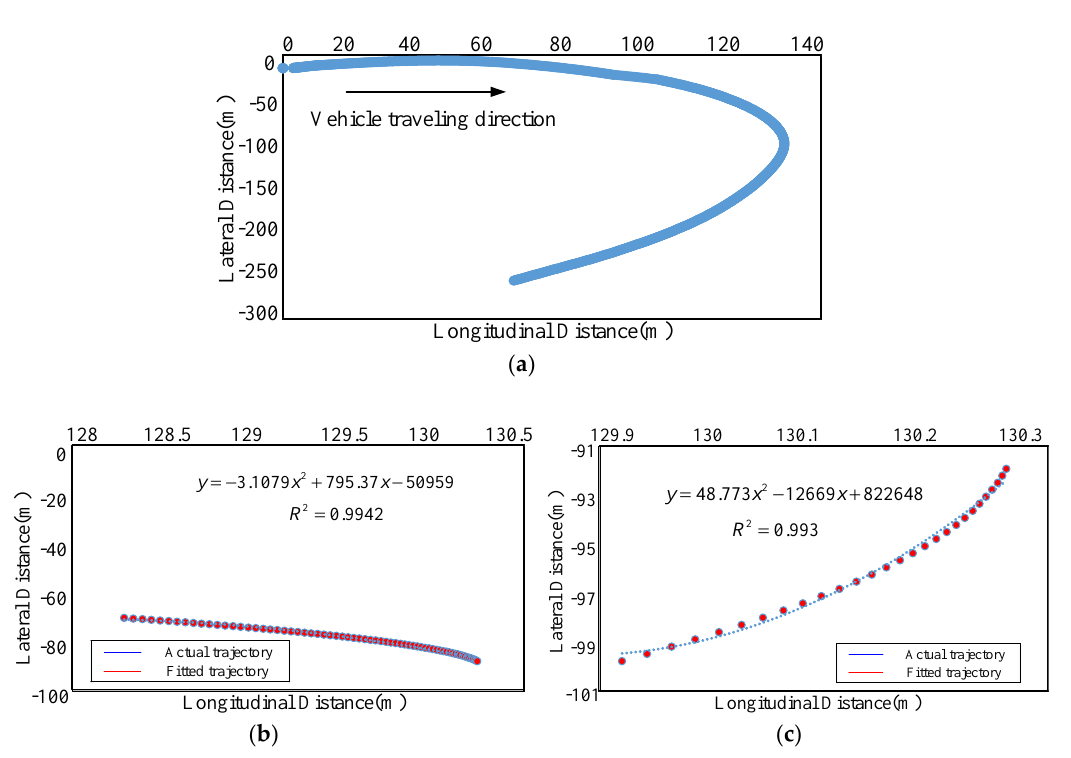
Figure 1. Trajectory fitting under normal right-steering: ( a ) Full trajectory; ( b ) The first paragraph trajectory; ( c ) The second paragraph trajectory.